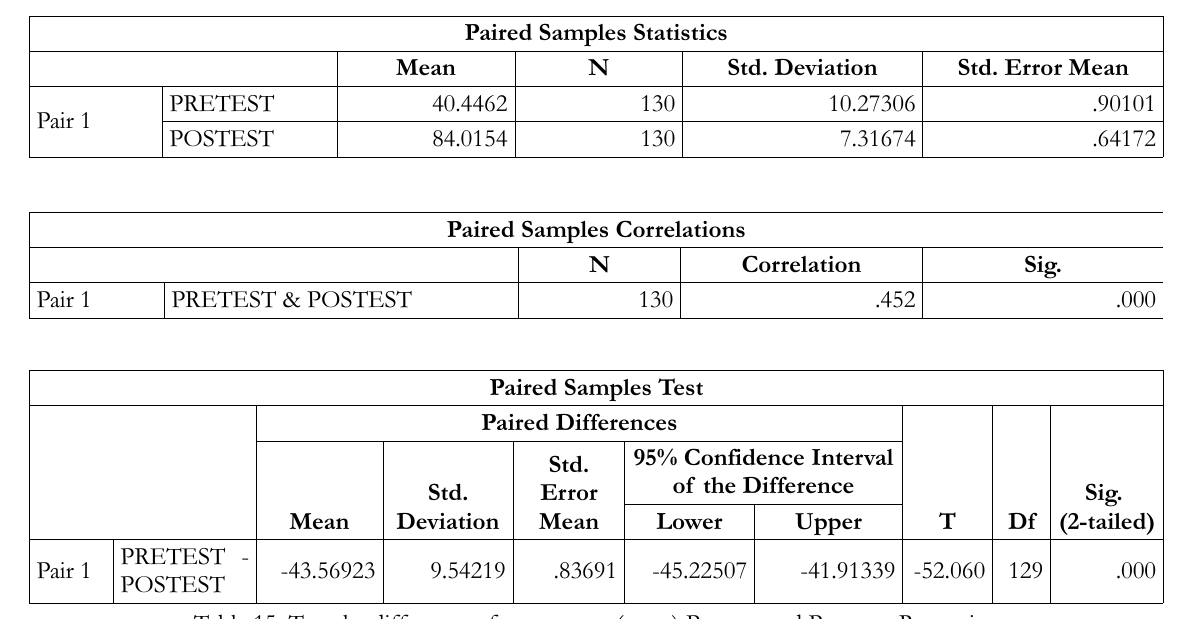
Table 15. Test the difference of two means (t-test) Pre-test and Post-test Reasoning